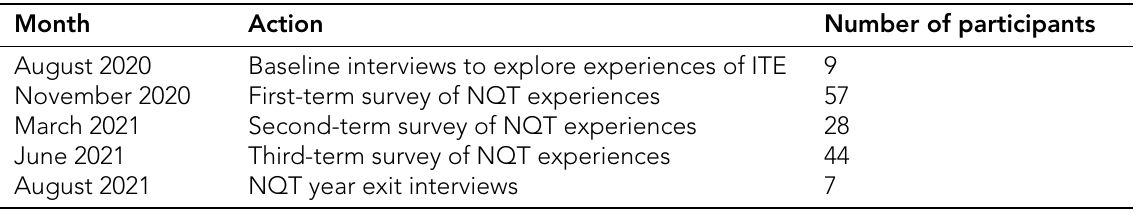
Table 1. Outline of the full study timeline and participants (Source: Authors,